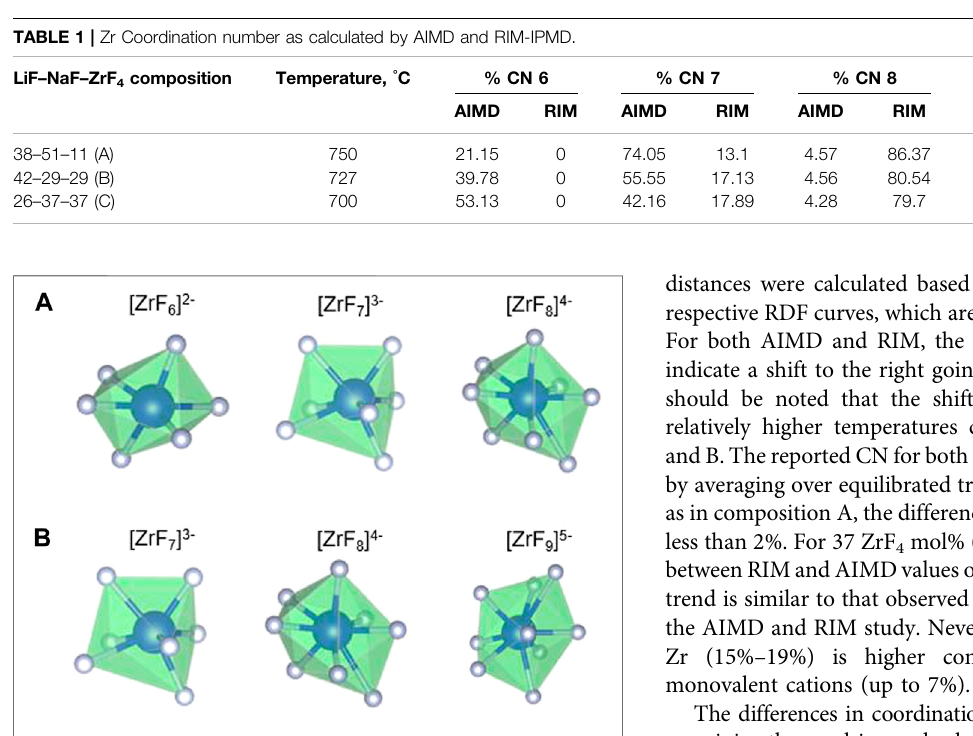
Frontiers in Physics |